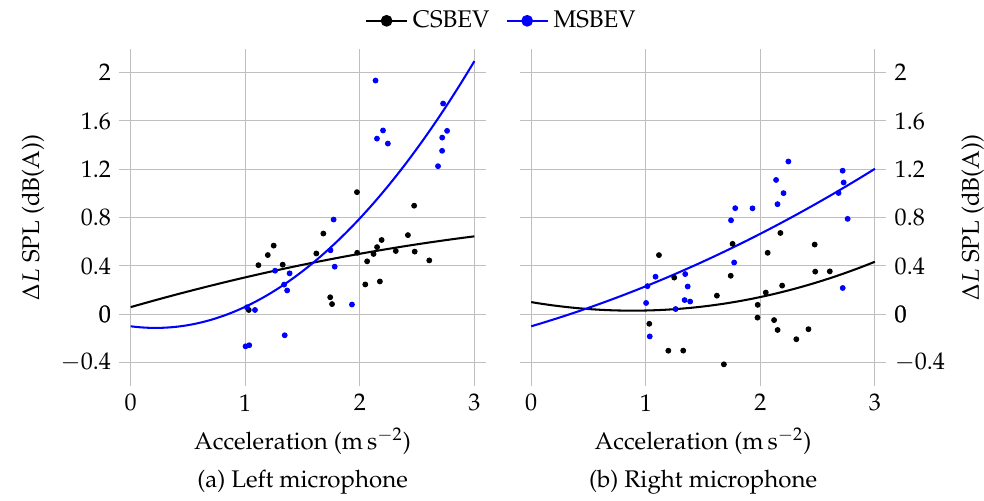
Figure 12. Accelerated noise behavior of the tire 255H on two different EVs.